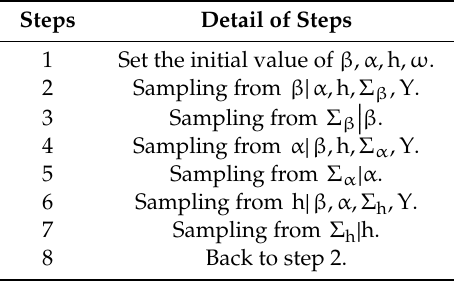
Table 1. Sampling steps of the Markov chain Monte Carlo (MCMC) method. Steps Detail of Steps 1 Set the initial value of β , α ,h, ω